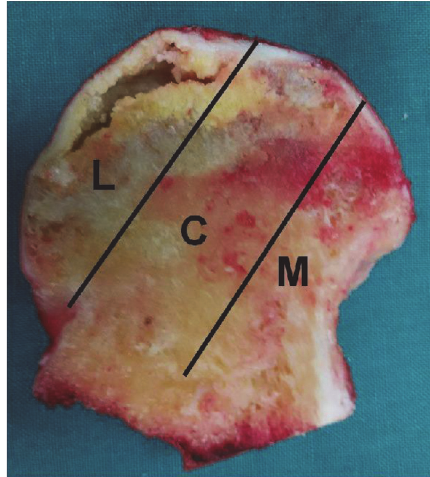
Figure 2: Image of coronal section of the femoral head showing three pillars of the femoral head: lateral (30%), central (40%), and medial (30%) [21].